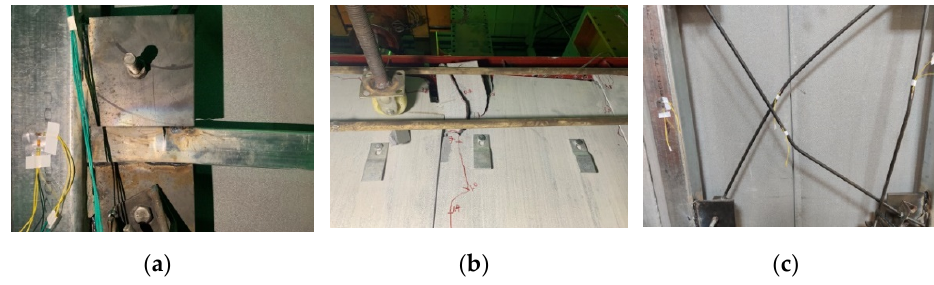
Figure 10. Test phenomena of FW-5 specimen: ( a ) Tear failure of the horizontal brace; ( b ) Wallboard crushed and broken; ( c ) Bracing deformation by the end of the test.